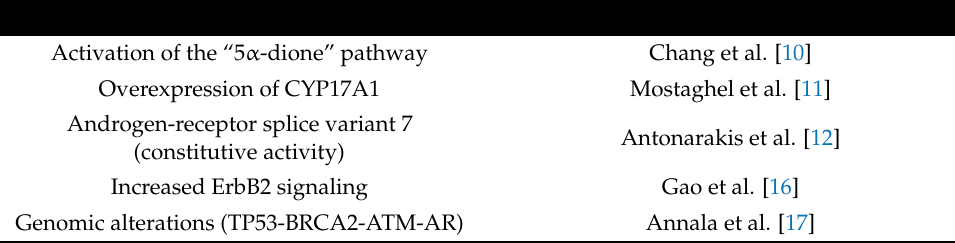
Table 1. Mechanisms of resistance to abiraterone.